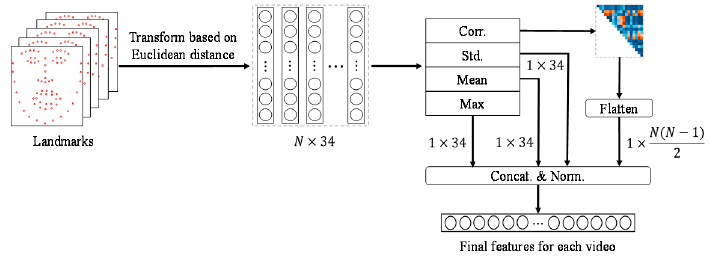
Figure 6. Generation of LMED-CF. Euclidean distance-based transformation is used [37].